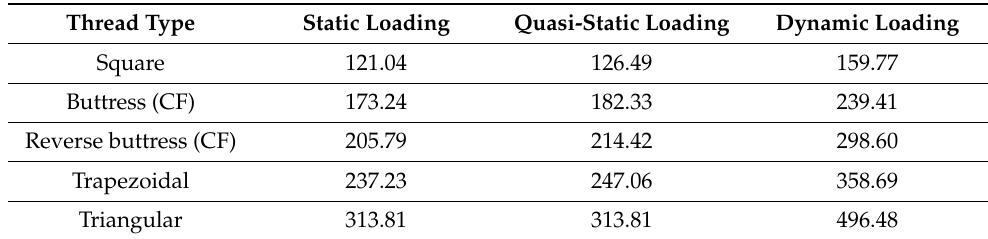
Table 4. Maximum von Mises stress (MPa) in the implant region of the implant under static, quasi- static and dynamic loading